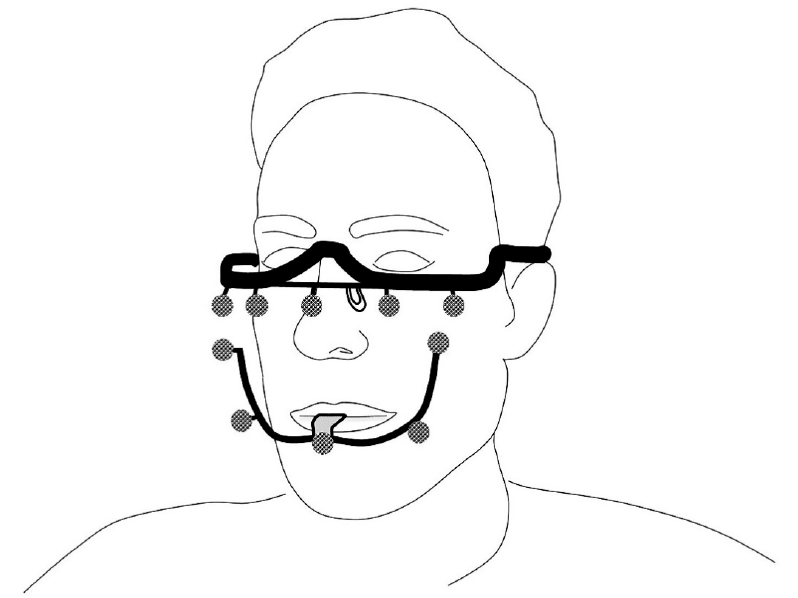
Figure 2. Sketch showing the 4D-CBCT setup. The subject is scanned with CBCT and subsequent 4D optical scanning in one procedure. The subject wears a maxillary frame resting on the nasal bridge and ears and a mandibular frame which is rigidly connected to the dental elements. Both frames are provided with five reflective markers that are visible on both the CBCT imaging and 4D optical tracking.